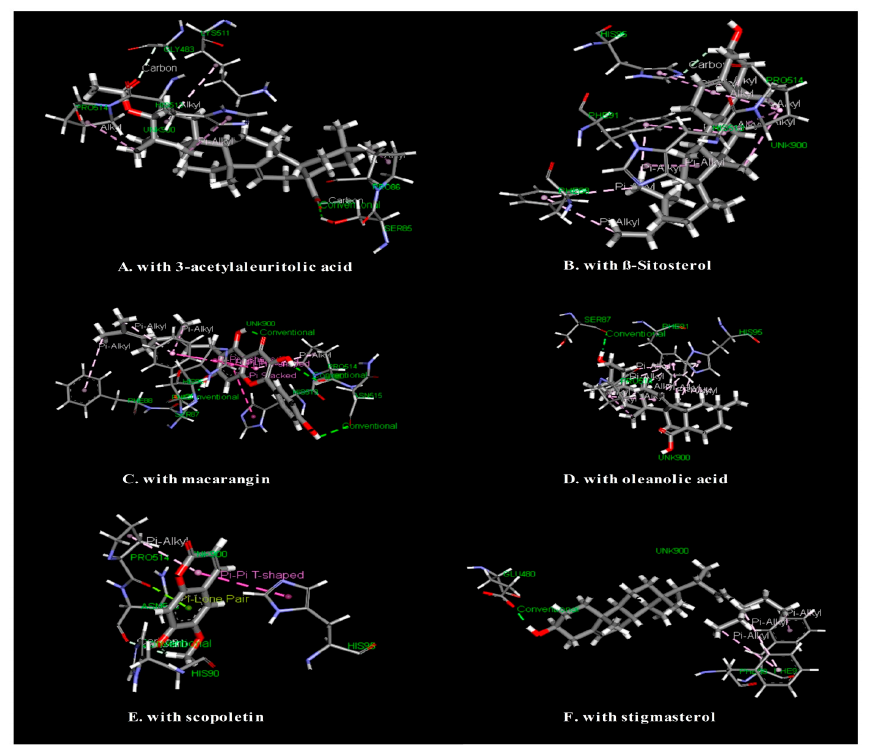
Figure 1. Visualization of the molecular docking interaction of isolated compounds of M. denticulata with COX-1 enzyme. with COX-1